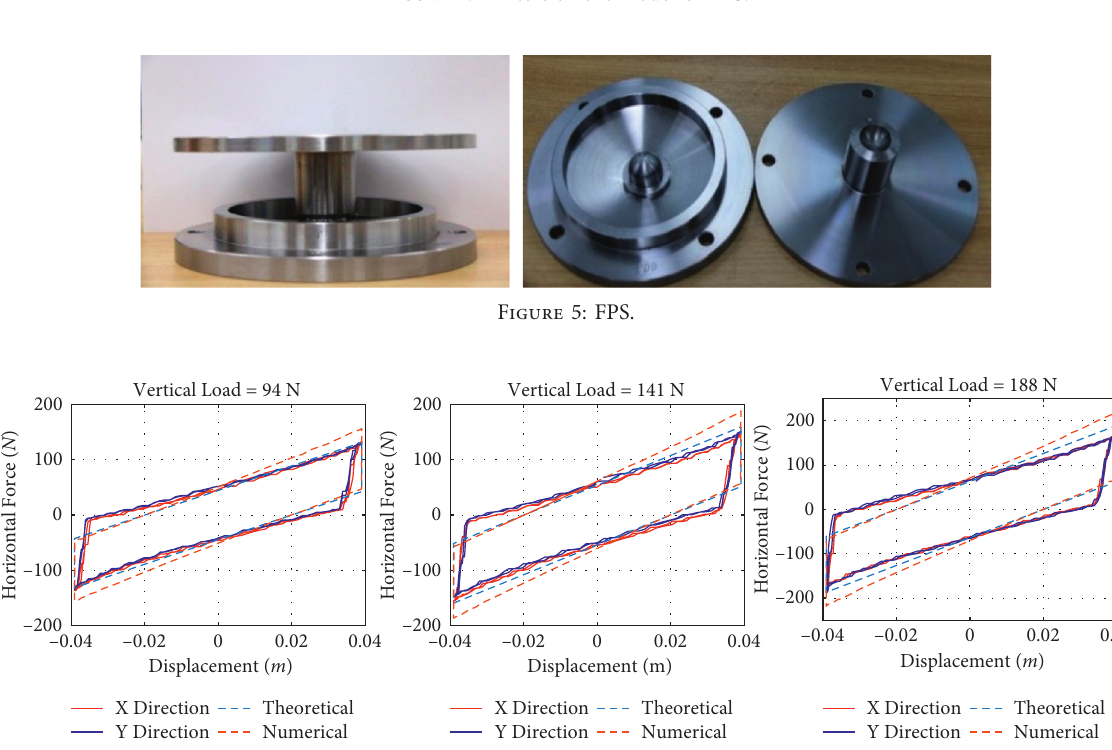
Figure 6: Hysteretic curve of numerical simulation and test results.